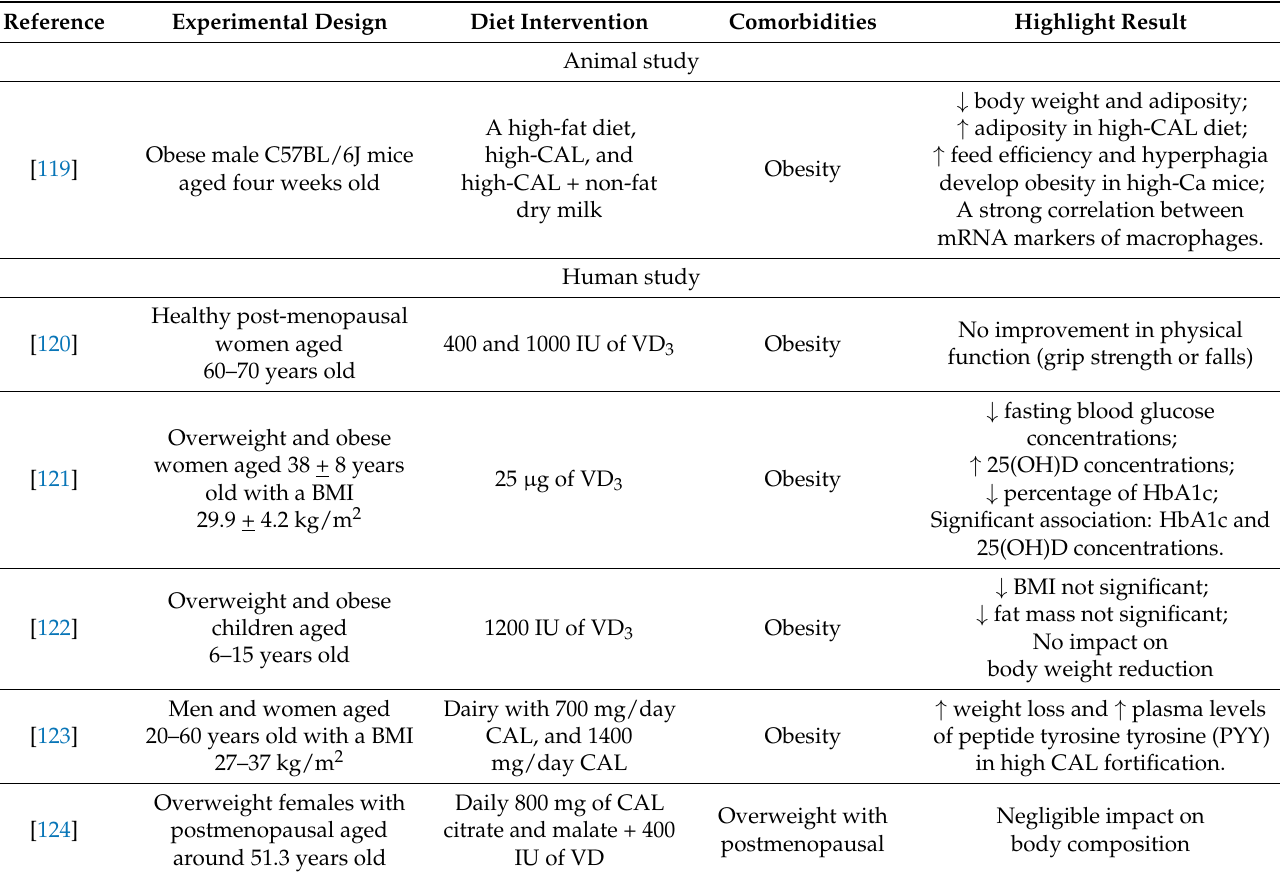
Table 7. The inadequate evidence of VD–CAL status in